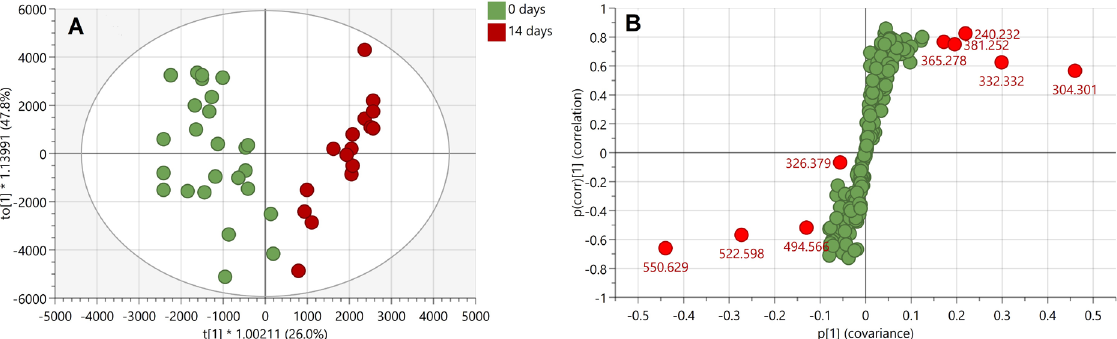
Figure 5. Multivariate statistical analysis of natural fingermark of 0 and 14 days of age. Panel A: OPLS- DA score plot (R 2 X(cum) = 0.829; R 2 Y(cum) = 0.833; Q 2 (cum) = 0.785) showing the discrimination between 0- and 14-days-old fingermarks deposited by the same person on aluminium slides. The ellipse indicates a Hotelling’s T 2 of 95%. Panel B: S-plot highlighting the most discriminating ions in 0- and 14-days-old fingermarks in the OPLS-DA model. The x-axis shows the magnitude of the variables and their importance, while the y-axis indicates reliability; the closer to ± 1, the more reliable. Red-labelled ions have a VIP score >1 (on a 95% confidence